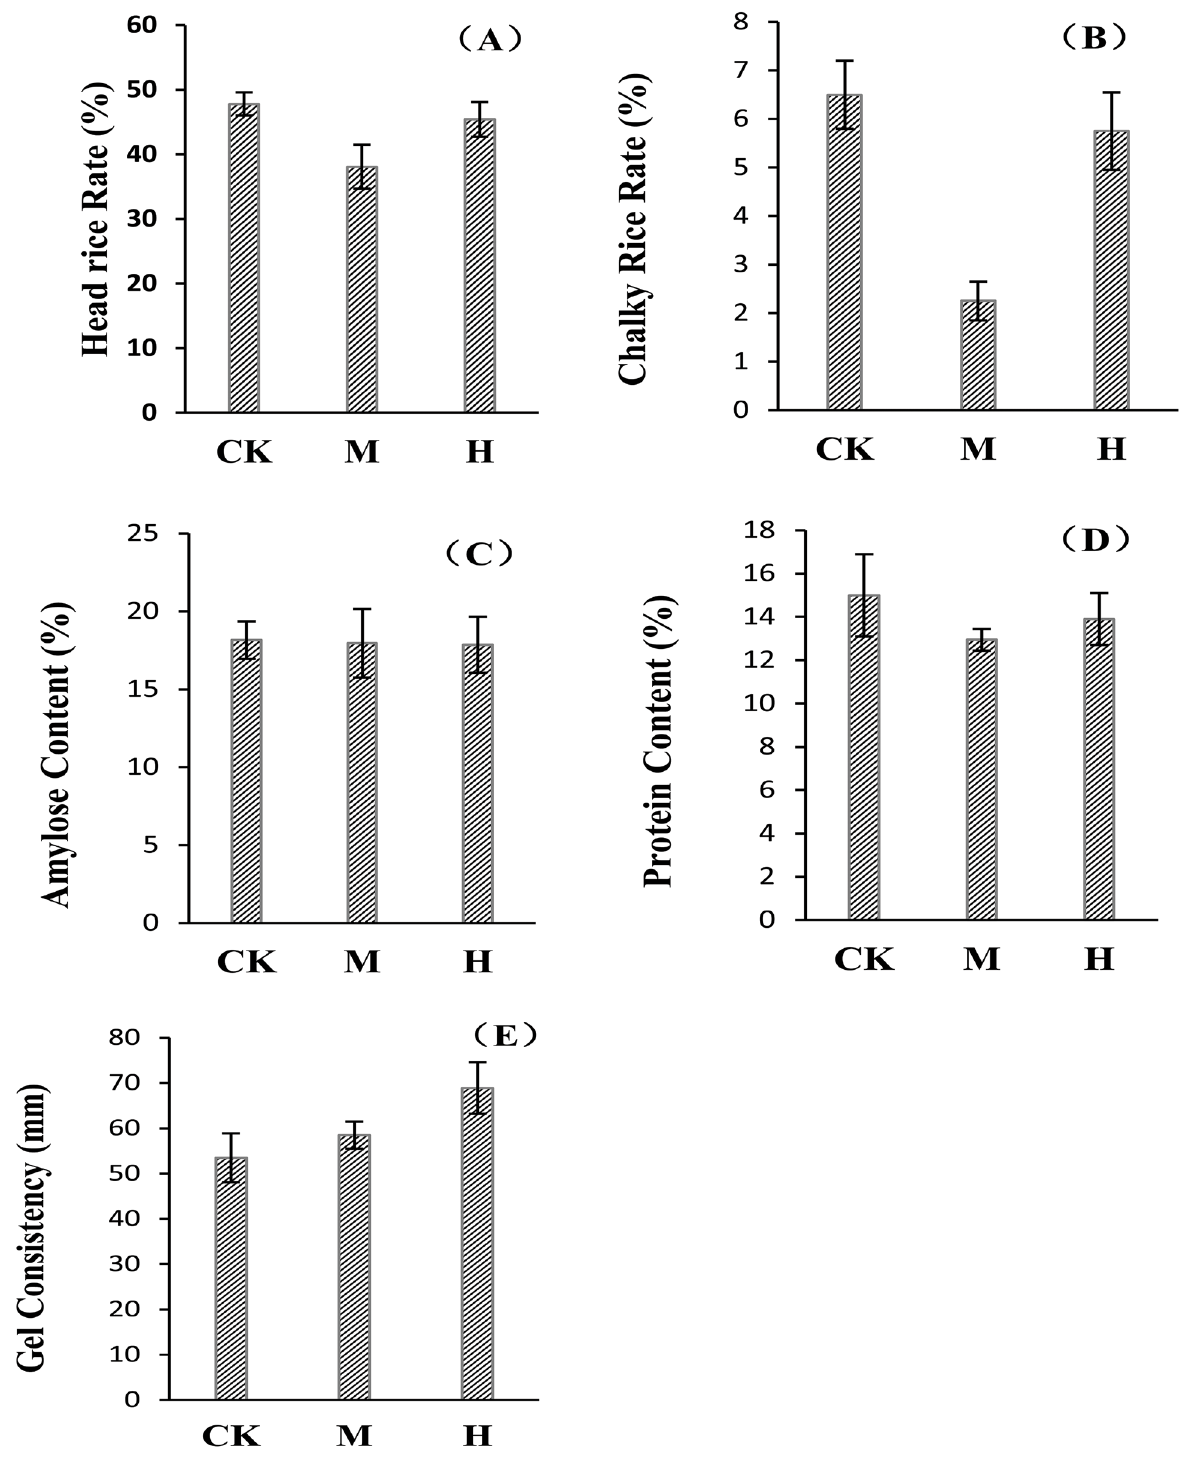
Fig 3. Changes of rice quality indices under the condition of increased atmospheric CO 2 levels and high temperature. (A)–(E) represent the Head Rice Rate, Chalky Rice Rate, Amylose Content, Protein Content and Gel Consistency, respectively.